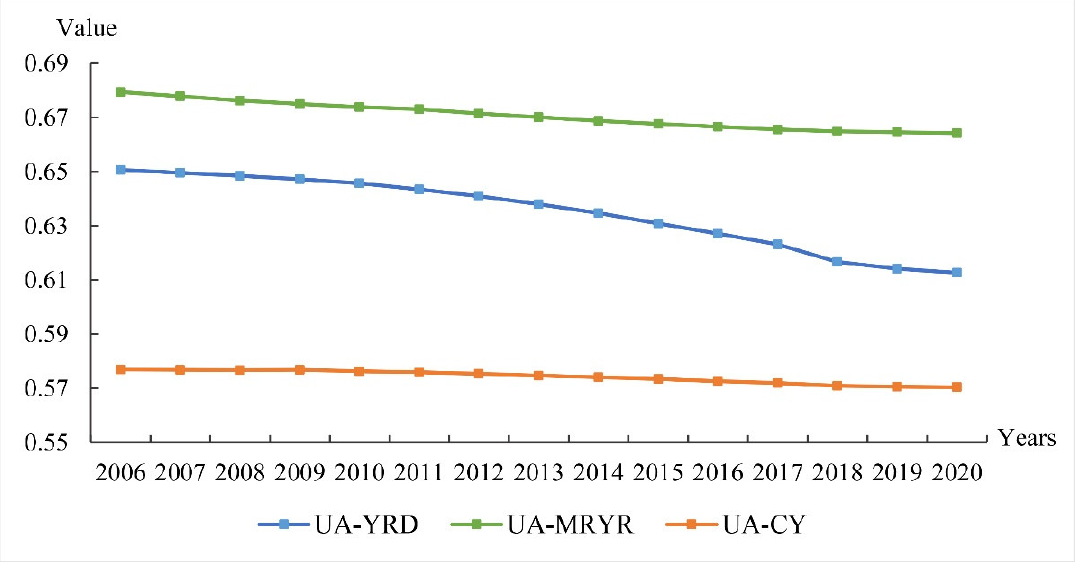
Figure 5. The temporal changes of AESV in three major urban agglomerations, 2006–2020.